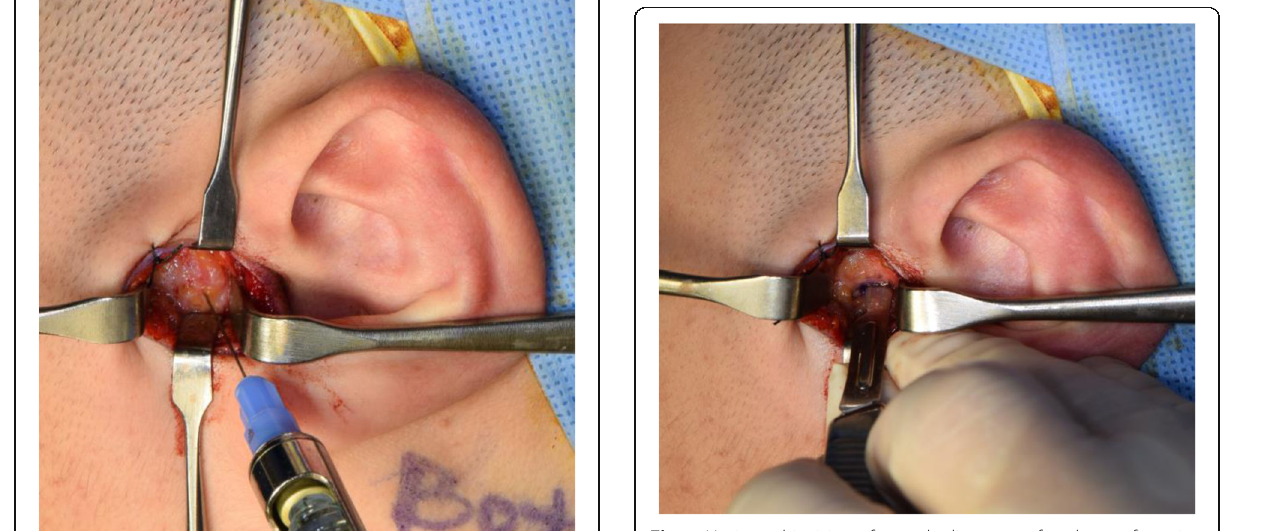
Fig. 4 Horizontal incision of capsular ligament after the confirmation of condylar position. This layer is tagged with two 5-0 white Vicryls for ease of layer-by-layer suture